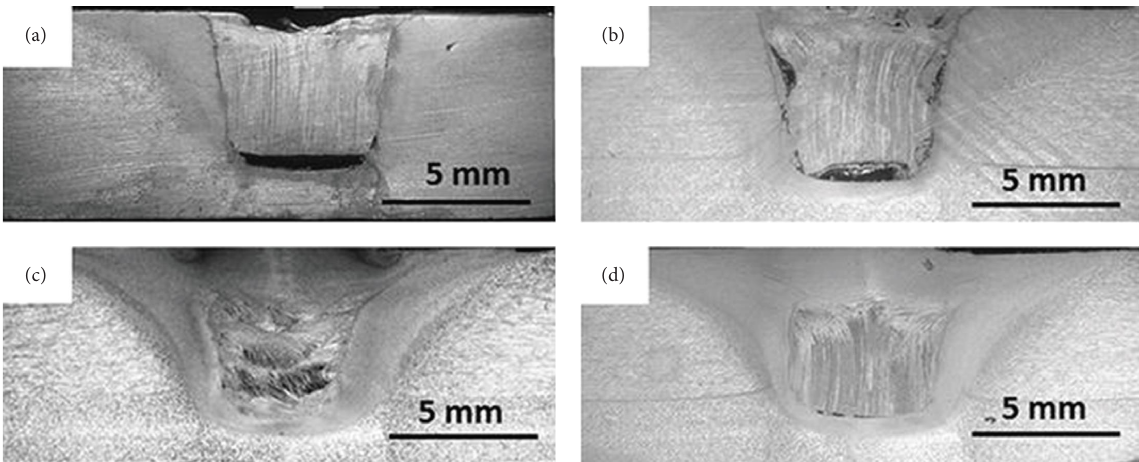
Figure 11: Te cross-sectional microscopic view of exit-holes flled with consumable pin at (a) 100rpm & 30sec, (b) 300rpm & 30sec, (c) 500rpm & 30sec, and (d) 700rpm & 30sec